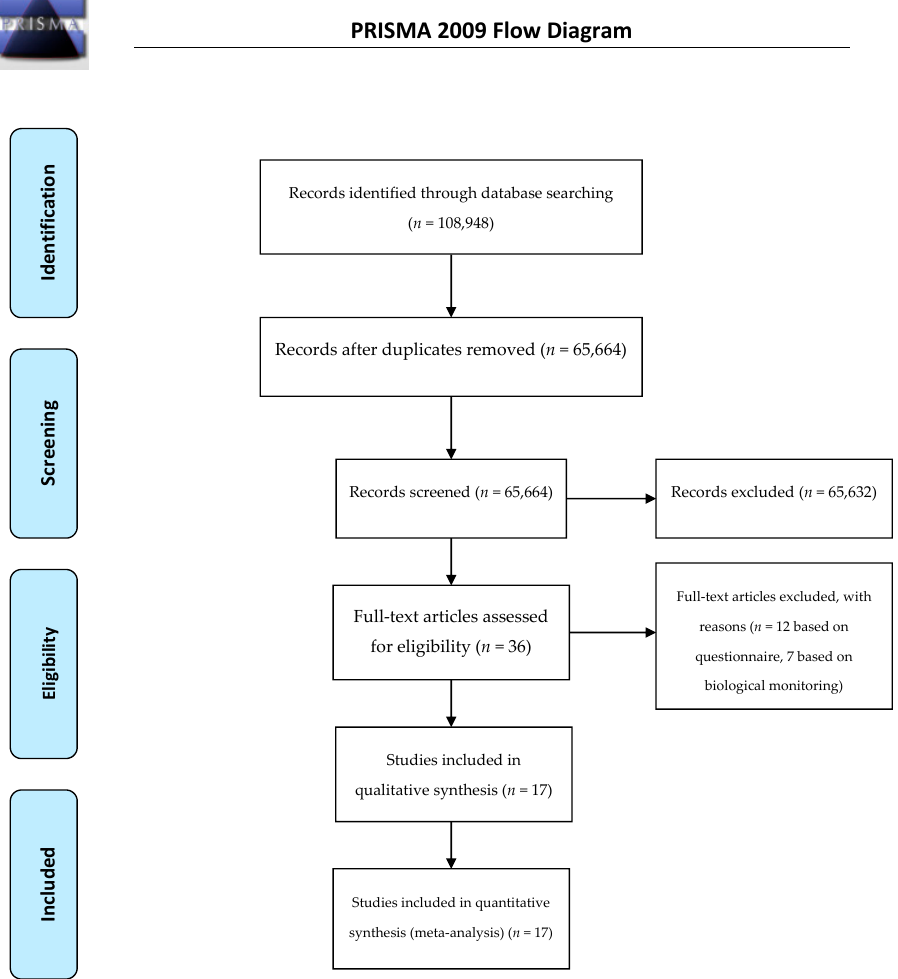
Figure 1. Flow-chart of the current systematic review and meta-analysis of alcohol consumption rate among truck drivers.